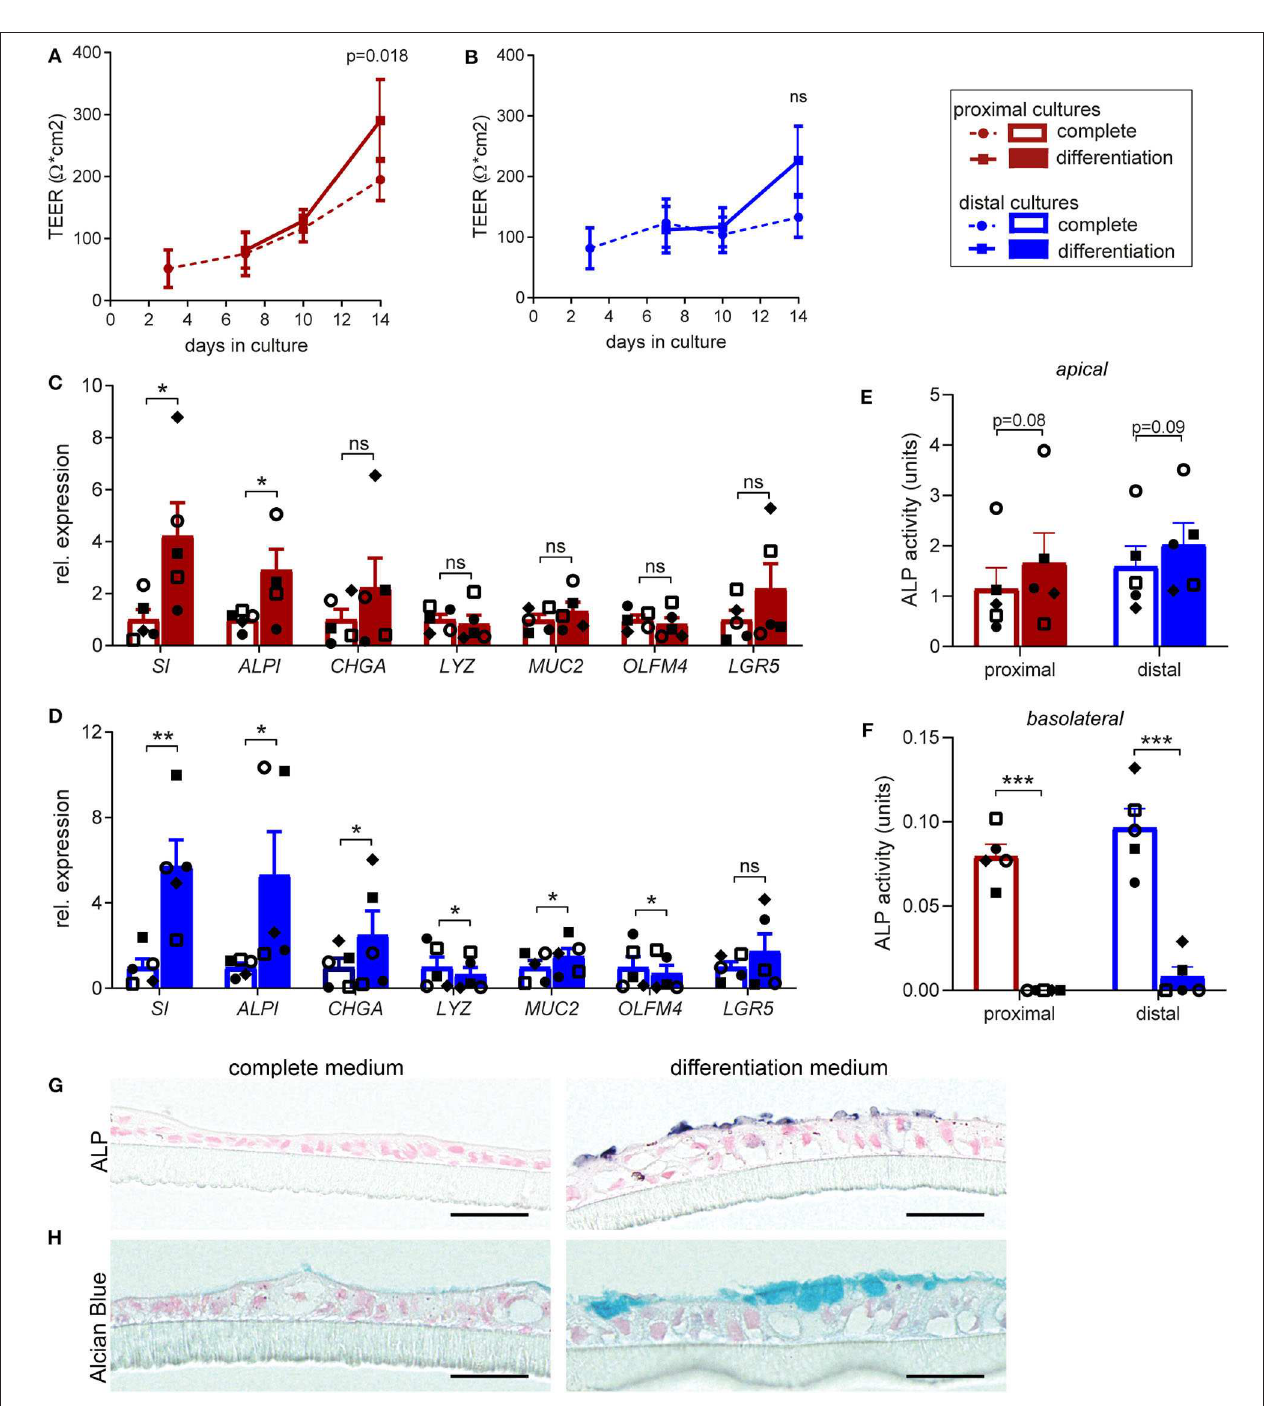
FIGURE 1 | Human fetal organoid monolayer cultures display functional brush border upon differentiation. (A,B) TEER values for (A) proximal and (B) distal organoid monolayer cultures maintained in complete medium or from day 7 in differentiation medium. (C,D) Relative expression levels of epithelial cell markers in differentiated (C) proximal and (D) distal cultures, compared to the level of expression in undifferentiated cultures at day 14. (E,F) Alkaline phosphatase activity levels (units = µ g pNPP/min) in culture supernatant of undifferentiated and differentiated proximal and distal cultures at day 14 detected in (E) apical medium and (F) basolateral medium. (G) Alkaline Phosphatase and (H) Alcian blue staining of embedded proximal transwell cultures in complete or differentiation medium at day 14 of culture. n = 5, values are mean ± SEM. * p < 0.05, ** p < 0.01, *** p < 0.001 as determined by ratio-paired t -test between complete and differentiated cultures. Black scale bar equals 20 µ